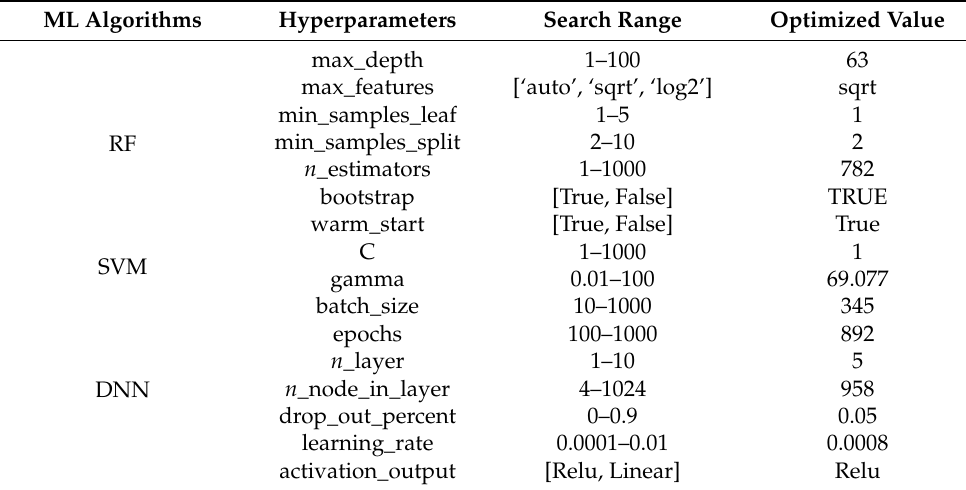
Table 6. Search range and optimized hyperparameters for the tested ML algorithms.